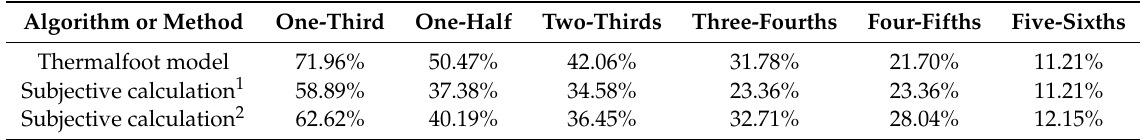
Table 1. Comparison with two subjective calculation methods. (Subjective calculation 1 and subjective calculation 2 indicate the experts do not use and use auxiliary means such as ruler, respectively.)